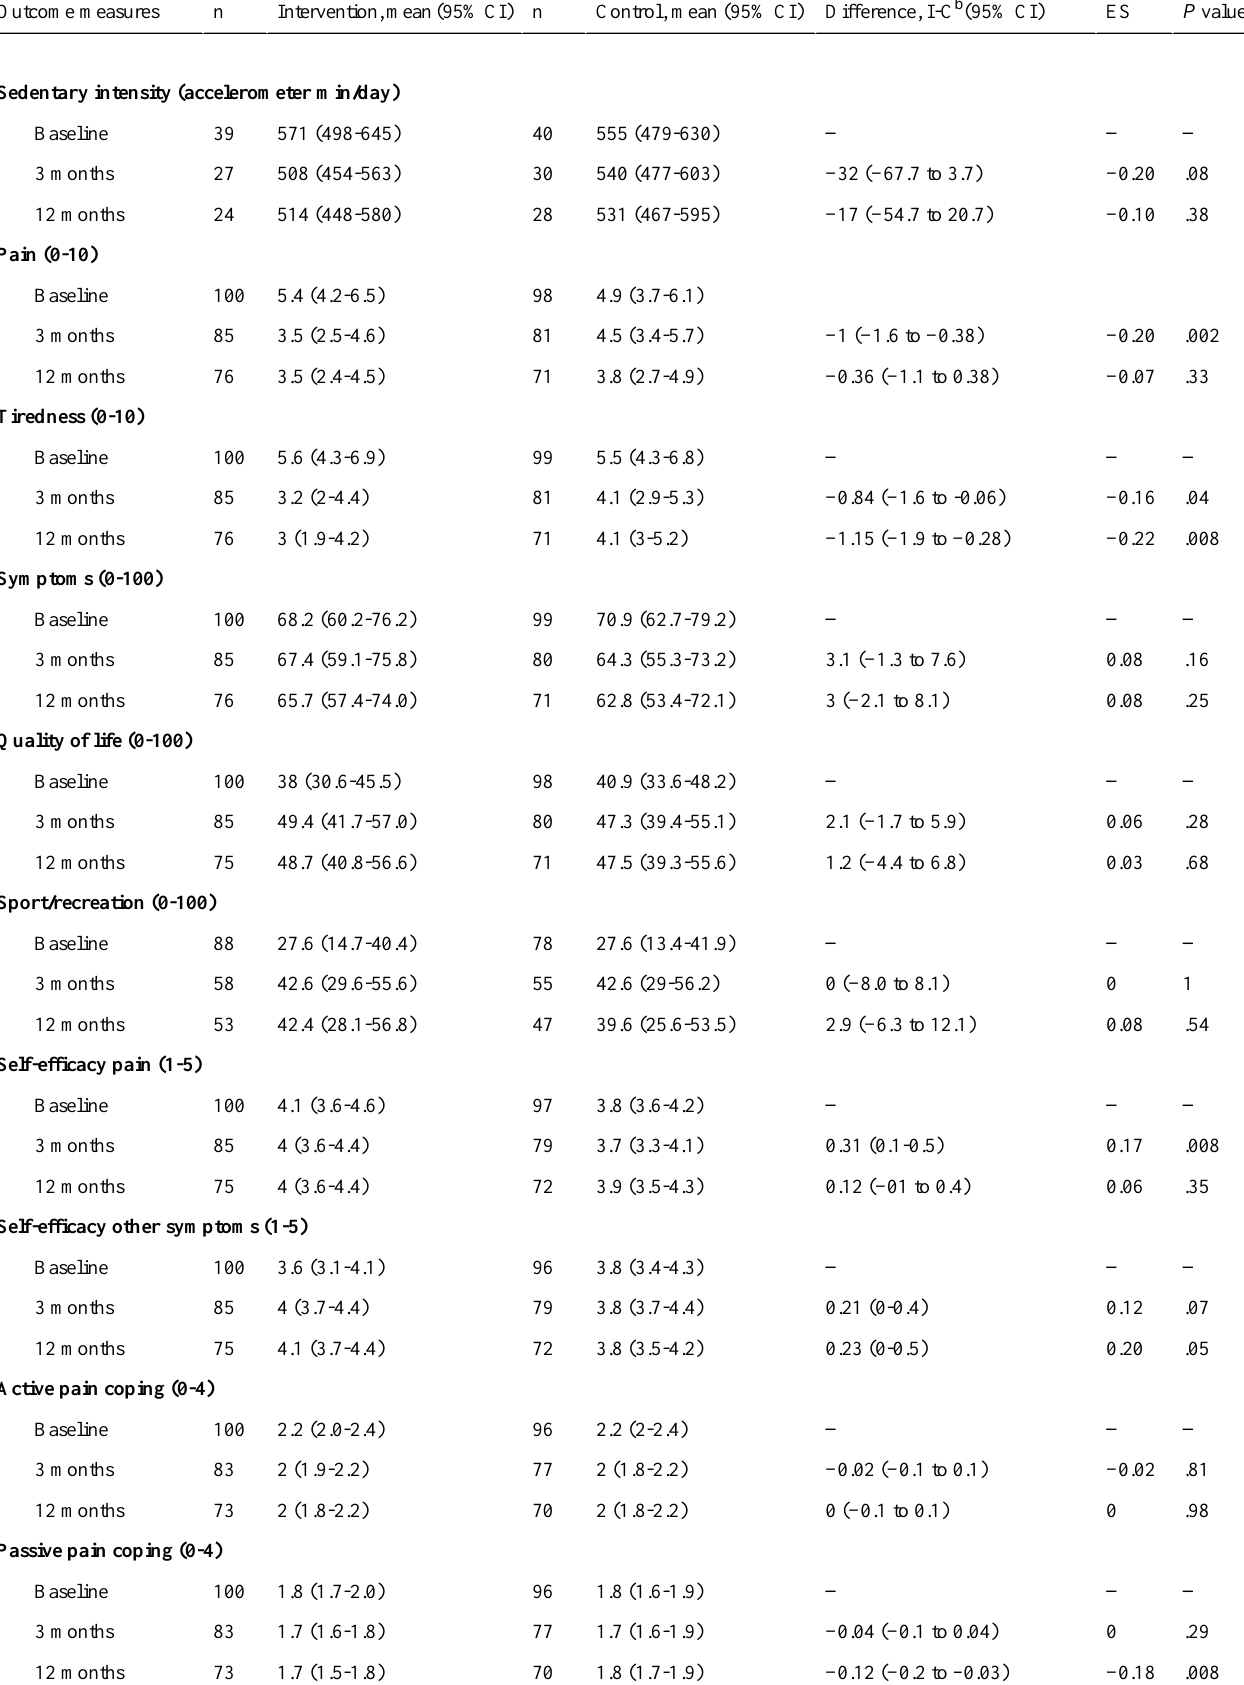
Table 3. Secondary outcome measures: improvements and differences between groups a